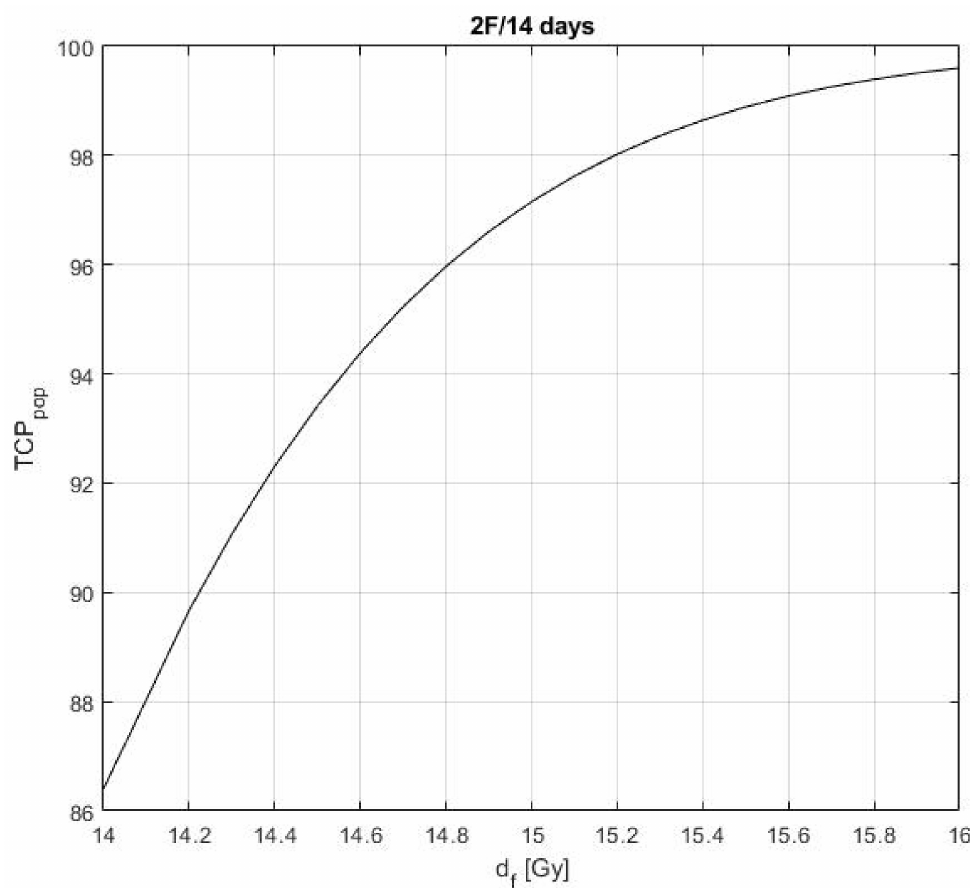
Figure 2. The population TCP in case of the two-fraction regimen, TCP 2F , as a function of the dose per